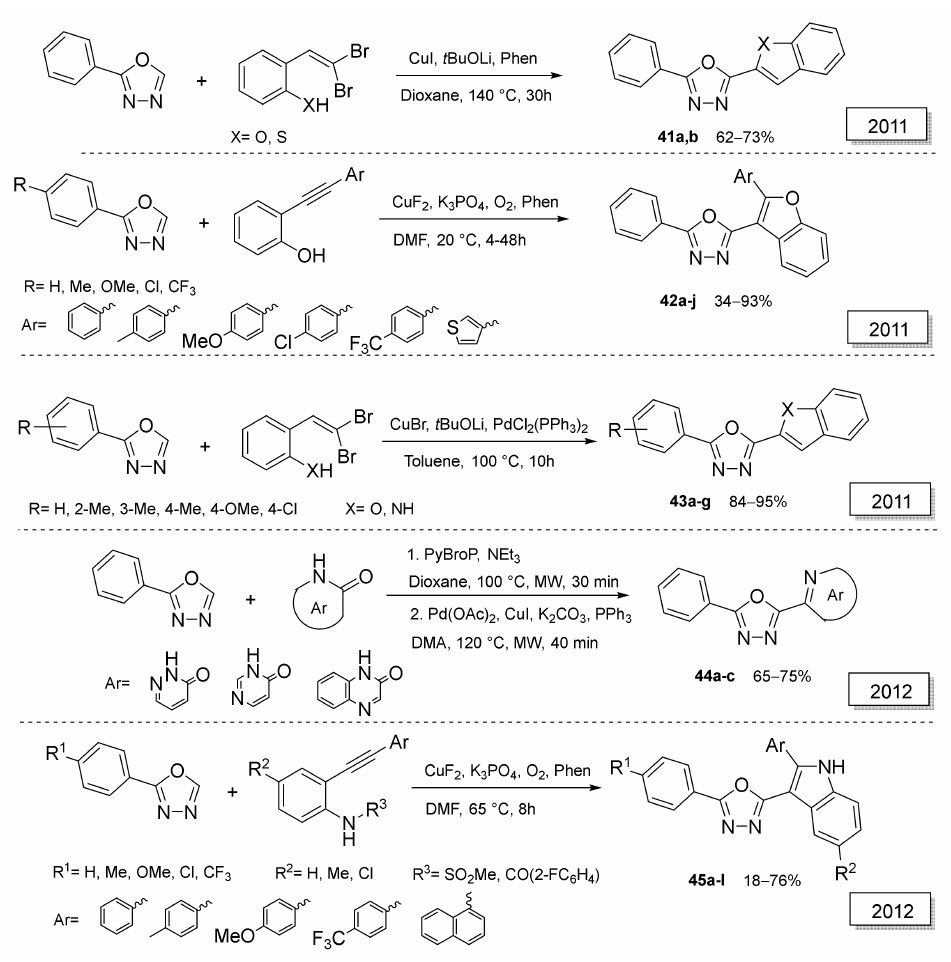
Scheme 10. Direct arylation of 1,3,4-oxadiazoles by